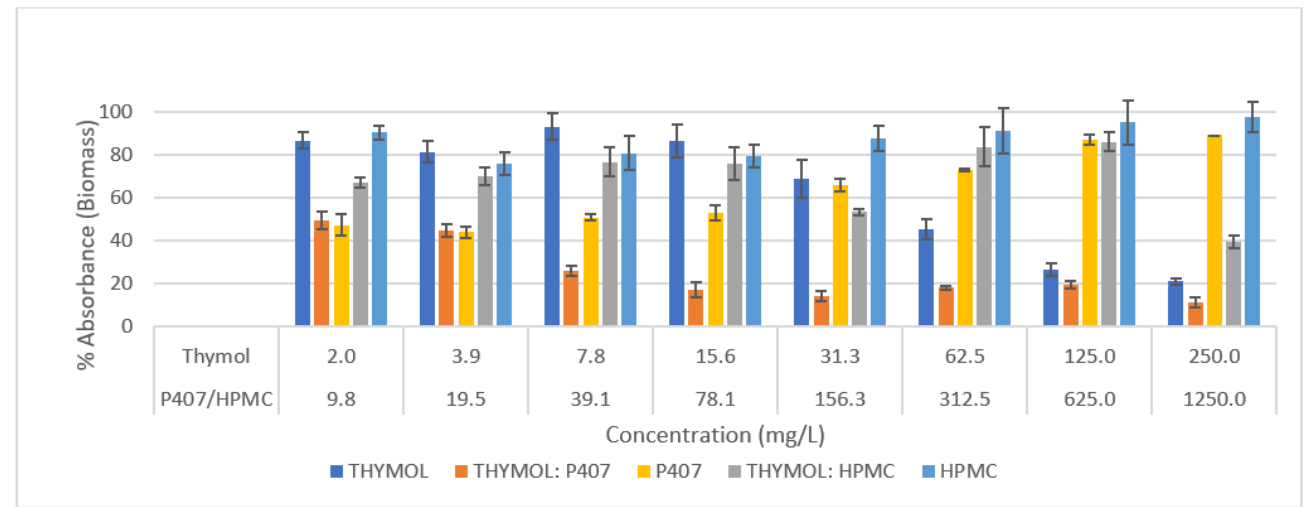
Figure 1. Effect of thymol, Thymol-P407, P407, Thymol-HPMC and HPMC on the inhibition of C. albicans biofilm formation ( n = 4) for 4 h at 37 °C using Crystal Violet assay. Each point represents the mean percentage ± SE.